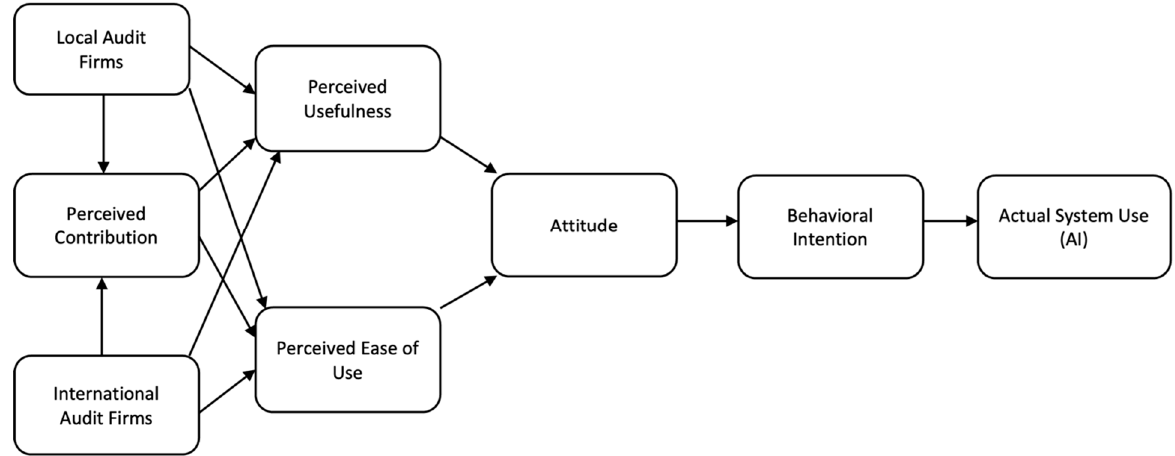
Figure 1. Research framework adapted from technology acceptance model (Davis 1989).